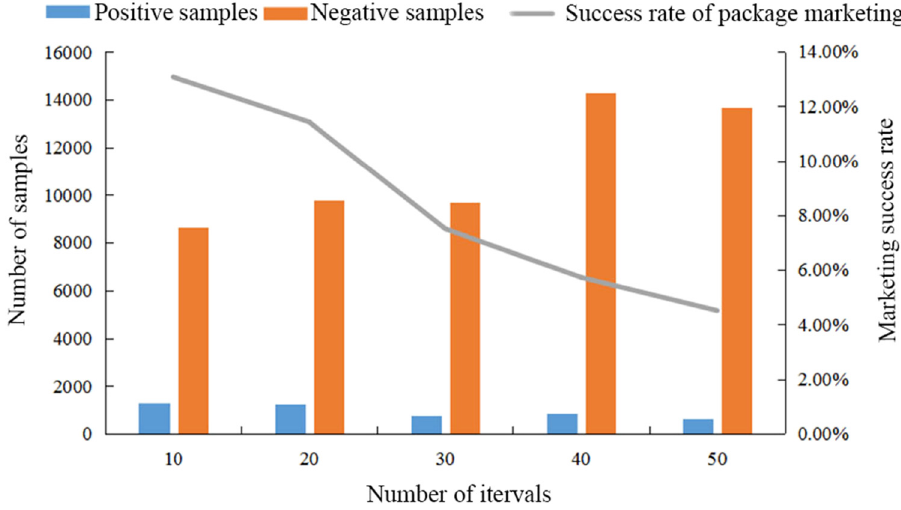
Figure 1: Marketing success rate under di ff erent